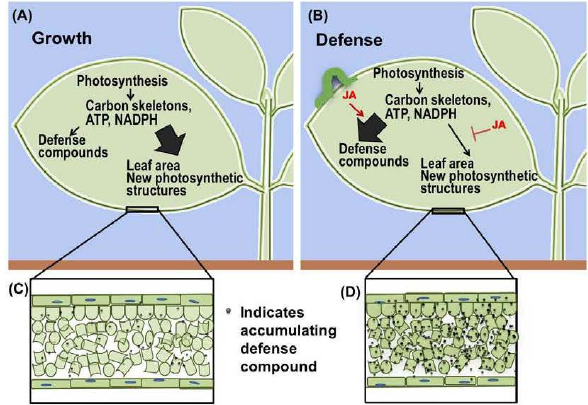
Figure 1. Jasmonate (JA) induces the re-budgeting of resources from tissue expansion to the production of defense compounds. ( A ) Plant growth is achieved using carbon skeletons, ATP, and NADPH from photosynthesis; ( B ) During the JA-mediated defense response, carbon skeletons, ATP, and NADPH that could otherwise contribute to growth are used for de novo synthesis of defense compounds; ( C ) In the absence of biotic attack, defense compounds are produced at a low basal level; ( D ) JA triggers the accumulation of defense compounds accompanied by an arrest of tissue expansion. In defended leaf tissue, cell size is similar to that in undefended leaves but the leaf mass per area (LMA) may increase as a consequence of increase carbon deposition into defense compounds.